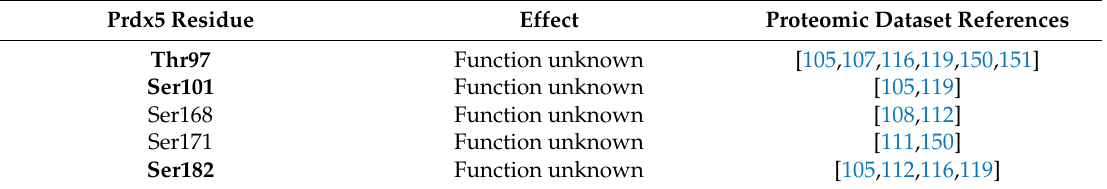
Table 5. Phosphorylation sites that correspond to human Prdx5 in proteomic studies are referenced are indicated. Phosphorylation sites that have been identified in proteomic screens in cancer models are in bold.